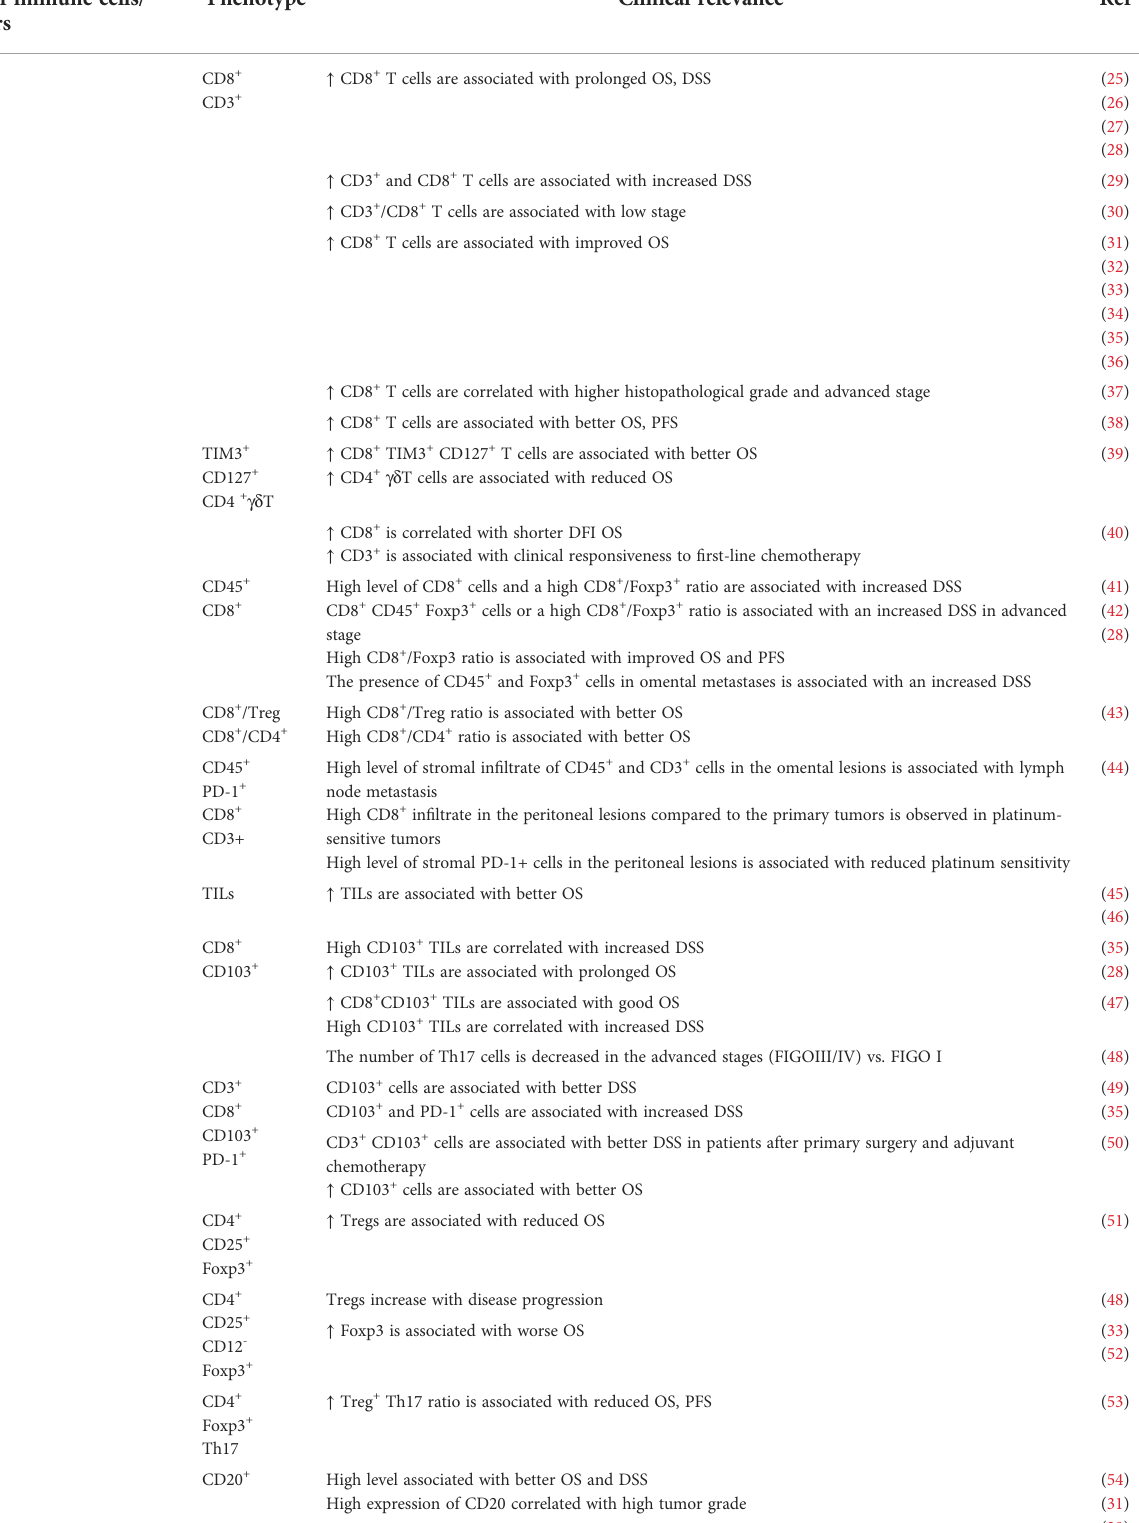
TABLE 1 Tumor tissue immune pro fi les and their clinical signi fi cance in ovarian